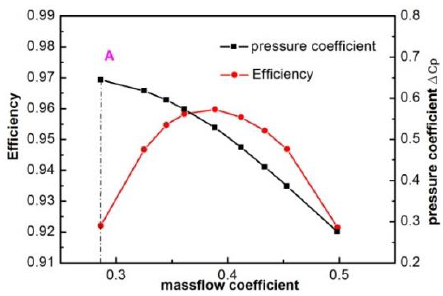
Figure 5. Characteristic lines of the quasi-3D model.